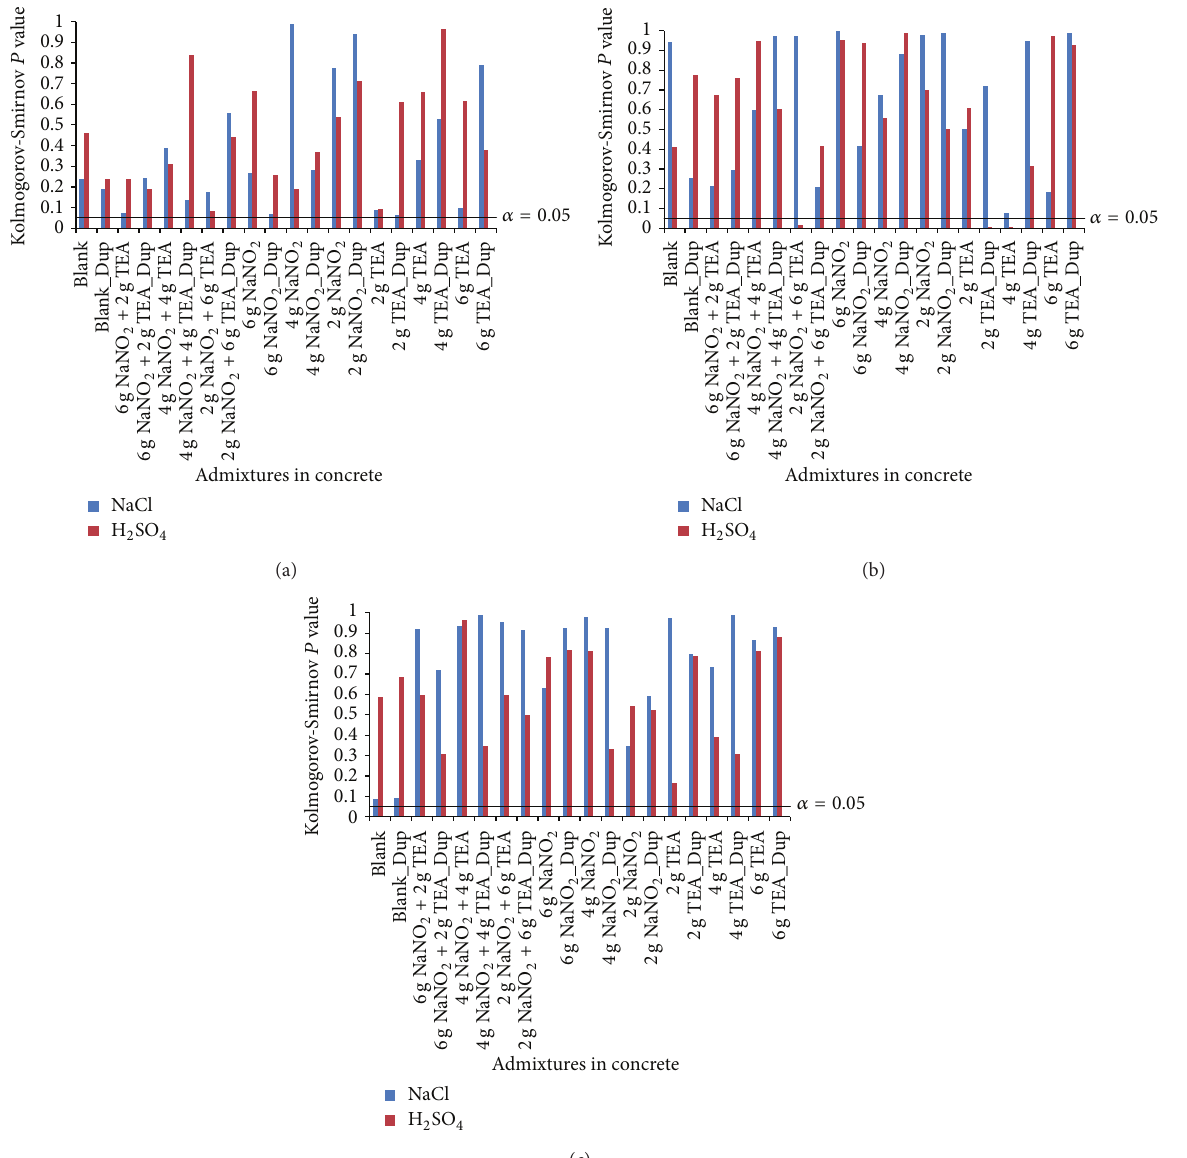
Figure 3: K-S goodness of fit test of measured corrosion test variables from concrete samples: (a) half-cell potential, (b) cell current, and (c) corrosion